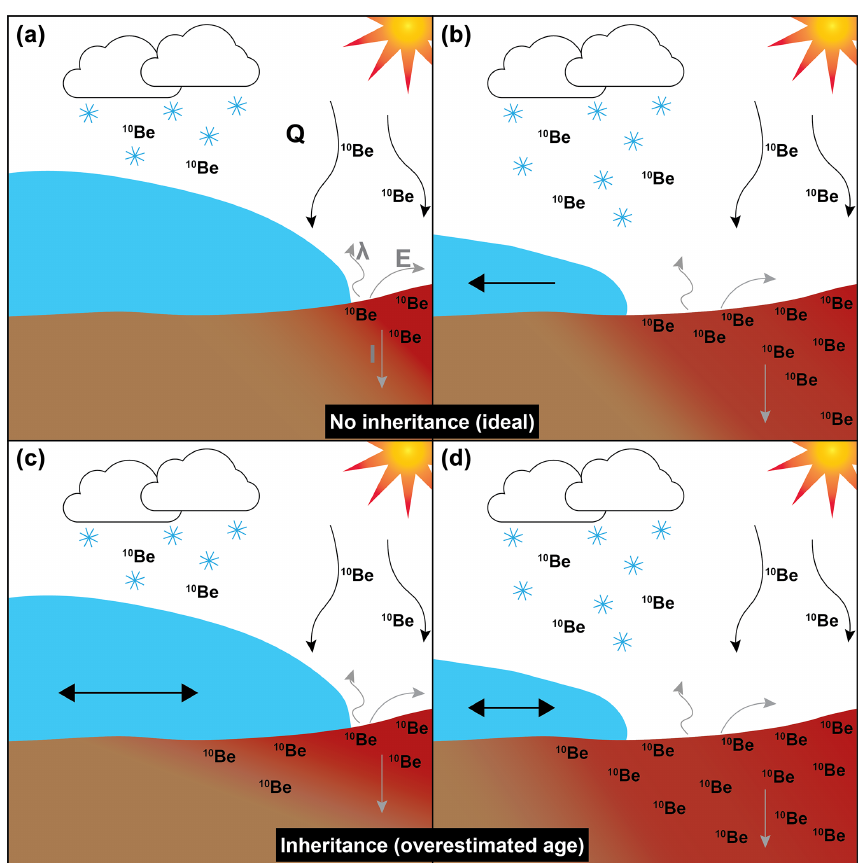
Figure 3. Conceptual diagram of meteoric 10 Be accumulation in soils during glacial advance and retreat. In “ideal” conditions, 10 Be accumu- lates in exposed soils by wet deposition (with snow) and dry deposition (by gravity as indicated by black arrows), and 10 Be concentrations beneath the glacier are negligible at background levels (a) . As the glacier retreats, 10 Be can begin accumulating in the recently exposed soil (b) and an inventory can be measured to calculate exposure duration. In the case in which the glacier has waxed and waned numerous times and the soils already contain a non-negligible “inheritance” concentration of 10 Be, the inventories would need to be corrected for 10 Be inheritance (c–d) to accurately determine exposure duration. Q represents of the flux of 10 Be to the surface, λ represents radioactive decay of 10 Be, E represents erosion, and I represents the migration of 10 Be from the surface to